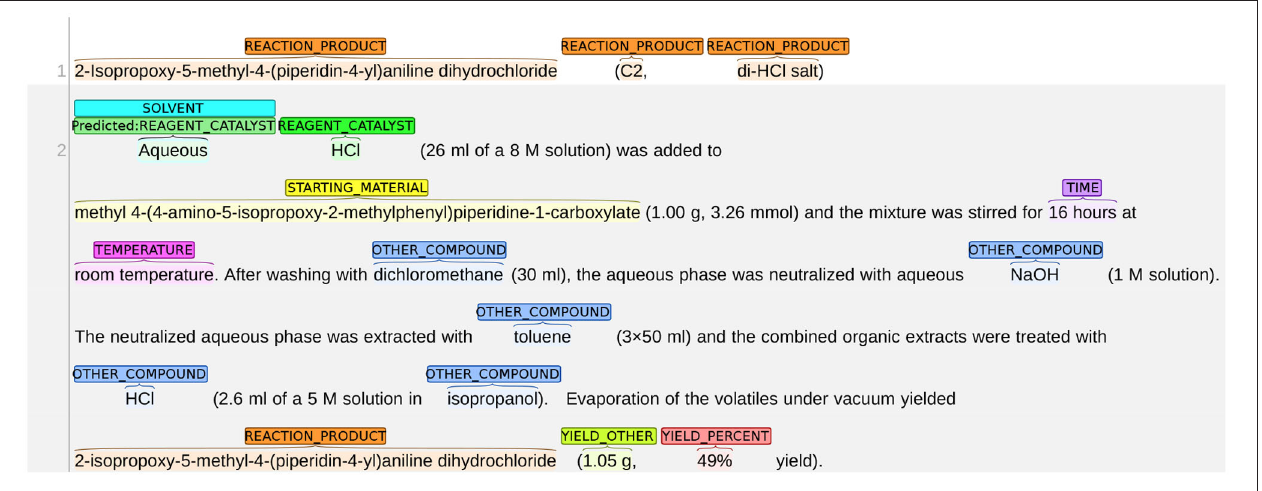
FIGURE 11 | An example of the system misclassifying REAGENT_CATALYST as SOLVENT.